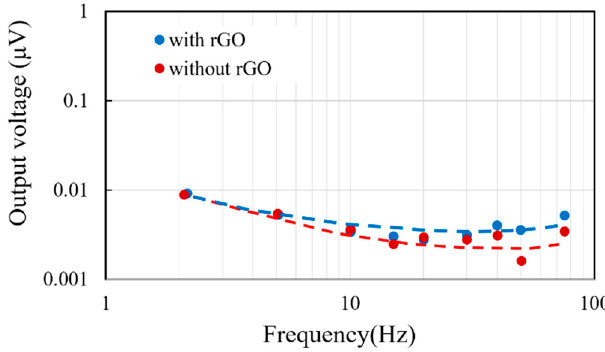
Figure 13. Frequency response of the average noise from the thermopiles with and without rGO.